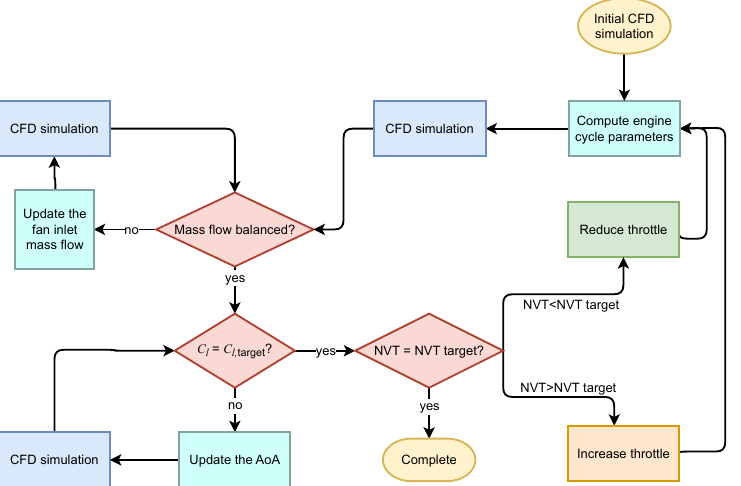
Figure 3. Flowchart of the methodology applied to compute a given flight point with specified lift and net translational force by combining CFD and thermodynamic cycle